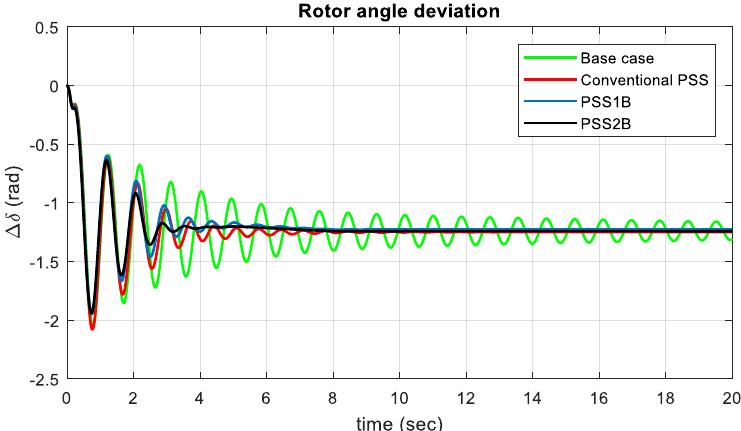
Figure 18. Rotor angle deviation of the power system at heavy loading.